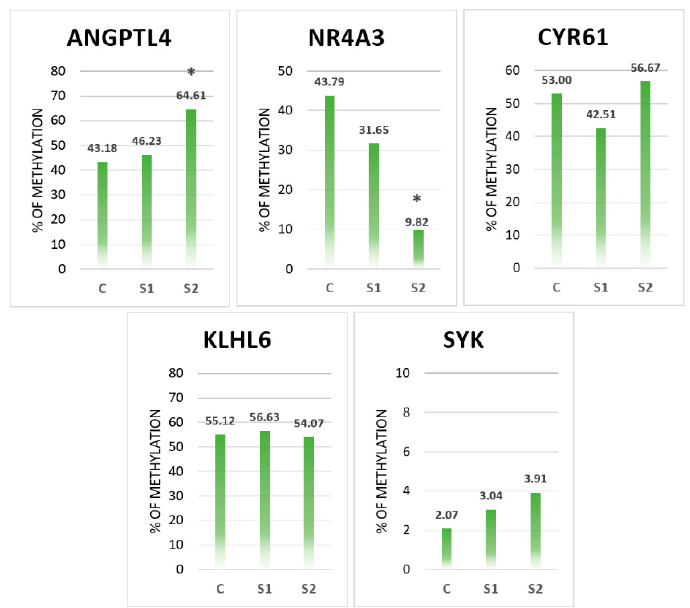
Figure 1. DNA methylation of the ANGPTL4, NR4A3, CYR61, KLHL6 and SYK genes in the liver. X-axis—groups: C—control, S1— Lactobacillus salivarius with GOS, S2— Lactobacillus plantarum with RFO; Y-axis—percentage of methylation. * p < 0.05 (n = 6).